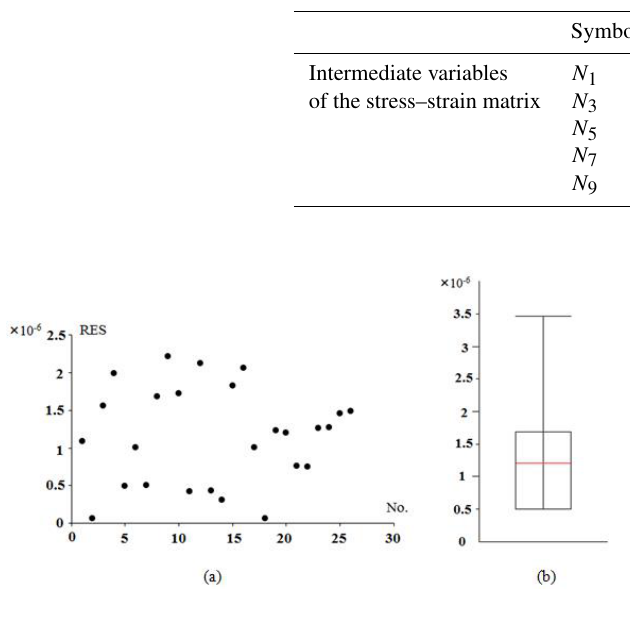
Figure 21. Residual error analysis of FBG-measured strain